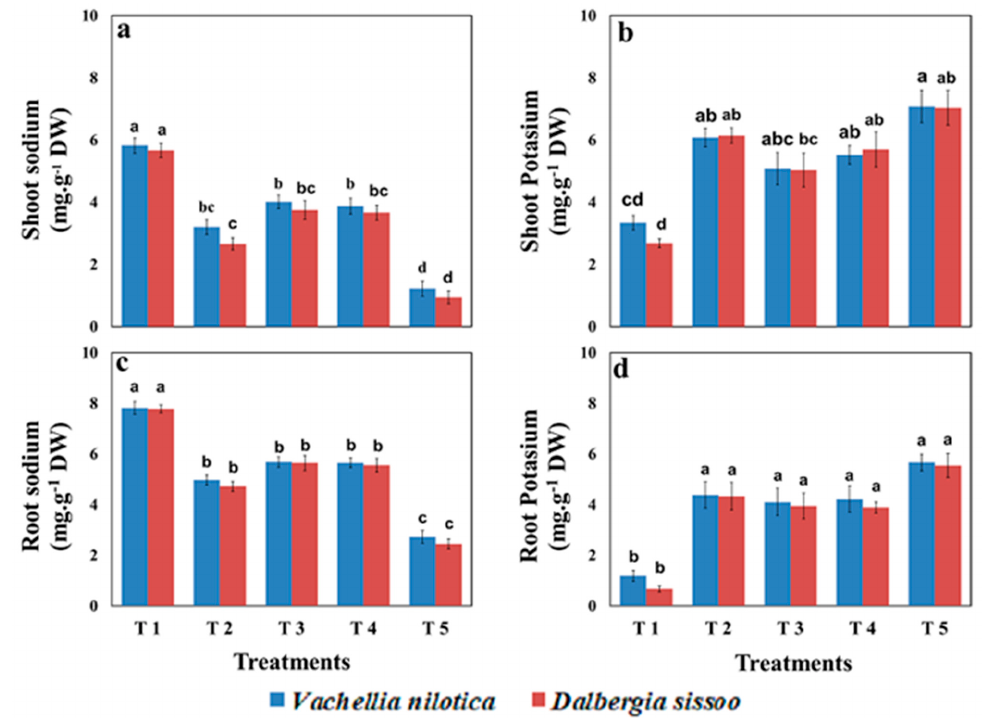
Figure 3. Effect of different organic amendments on ( a ) shoot sodium, ( b ) shoot potassium, ( c ) root sodium, and ( d ) root potassium of Vachellia nilotica and Dalbergia sissoo , where T1 = control, T2 = farmyard manure, T3 = poultry manure, T4 = slurry, T5 = biochar. The difference between lower case letters is the indication that values are significantly ( p < 0.05) different from each other.